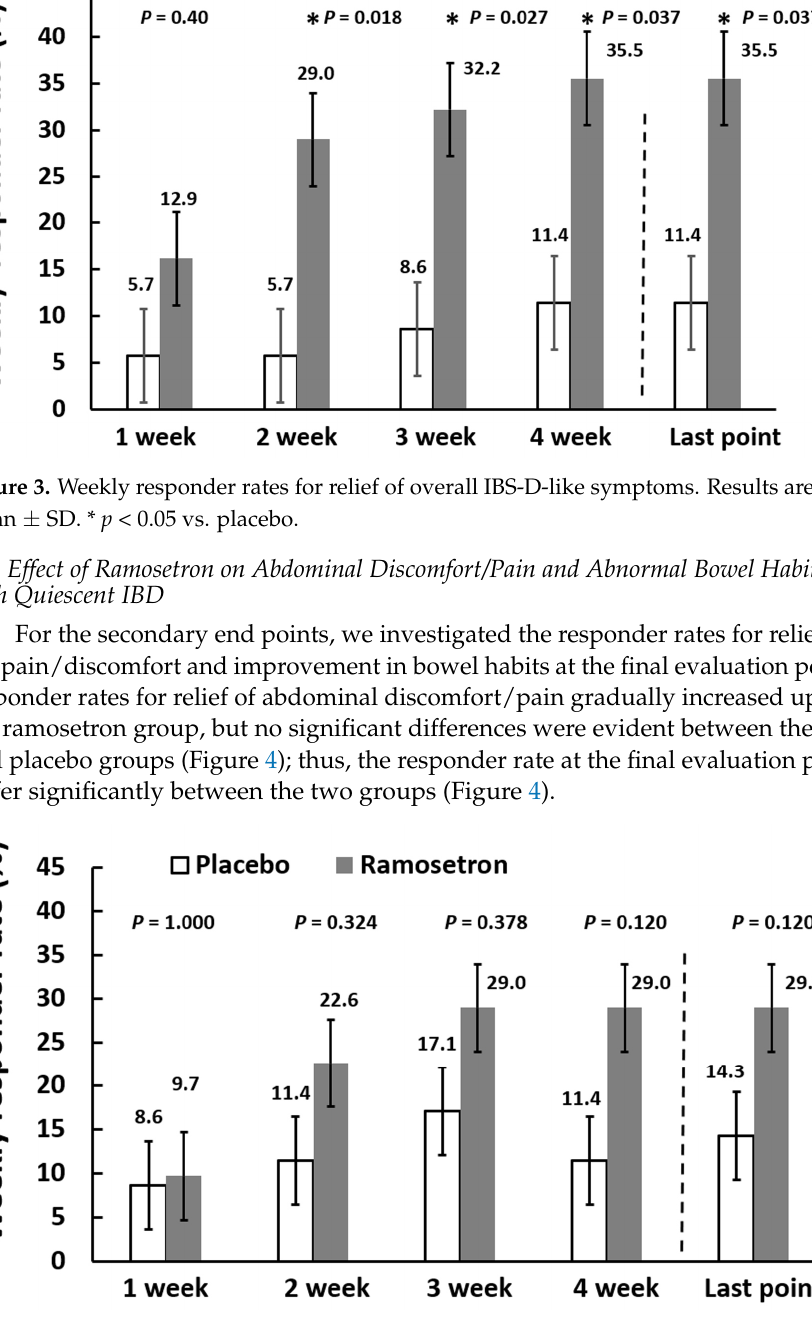
Figure 5 . Weekly responder rates for improvement of bowel habits. Results are expressed as mean ± SD. * p < 0.05 vs. placebo. 3.4. Effect of Ramosetron on Weekly Changes in Stool Frequency The reduction of stool frequency remained greater in the ramosetron group than in the placebo group during the experimental period (Figure 6). At the 4-week point from the start of treatment, the reduction was significantly greater in the ramosetron group than in the placebo group.